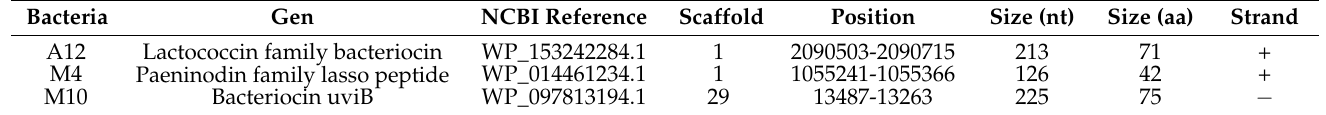
Table 2. Gen related to Bacteriocin-like protein in Lactococcus lactis (A12), Priestia megaterium (M4), and Priestia sp.